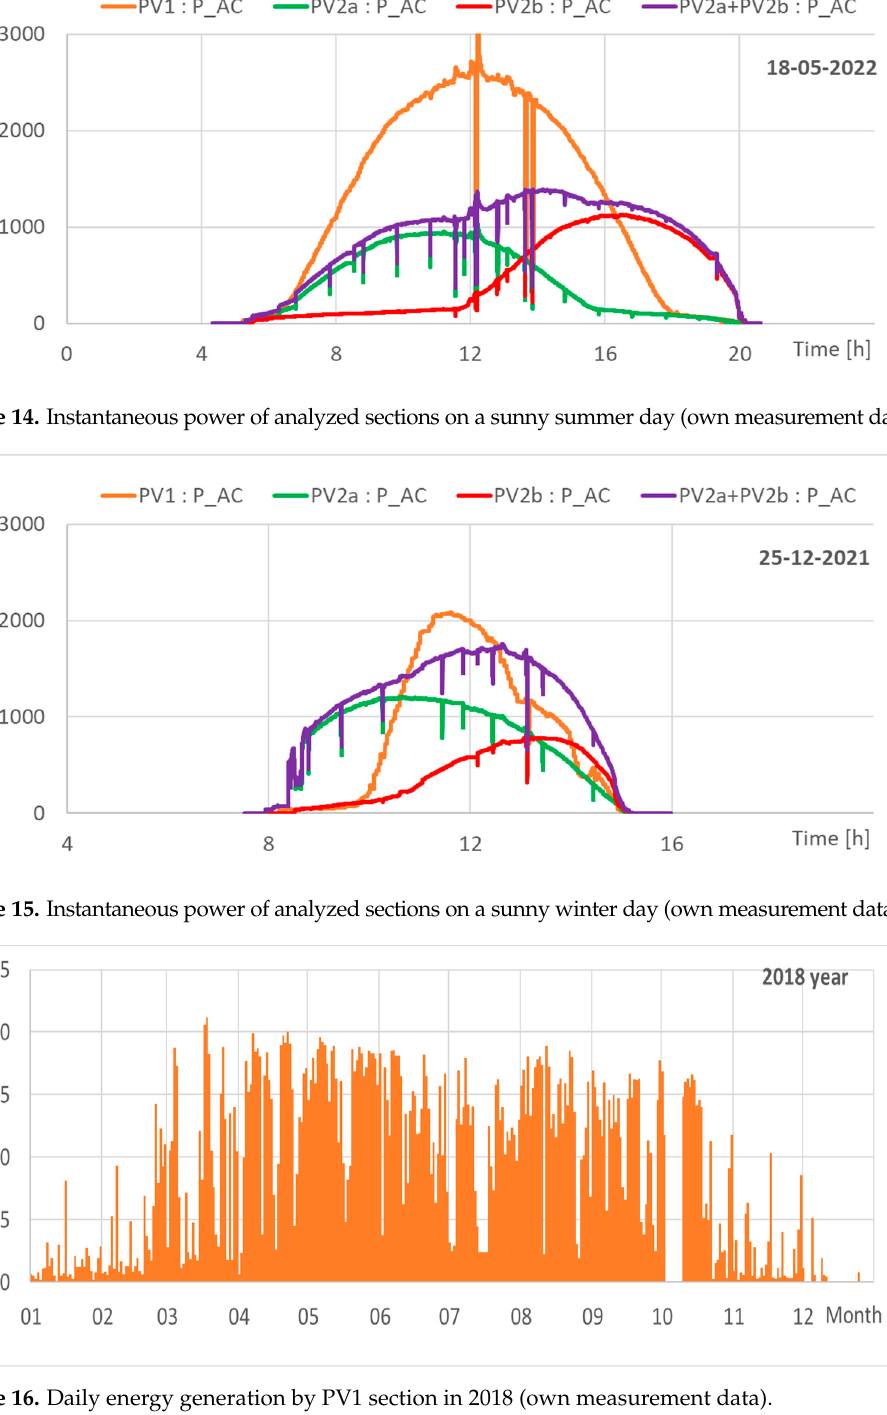
Figure 17. Daily energy generation by PV2a and PV2b sections in 2018 (own measurement data). Figure 18. Monthly energy generation by PV1 and PV2a+PV2b sections in 2021 (own measurement data).